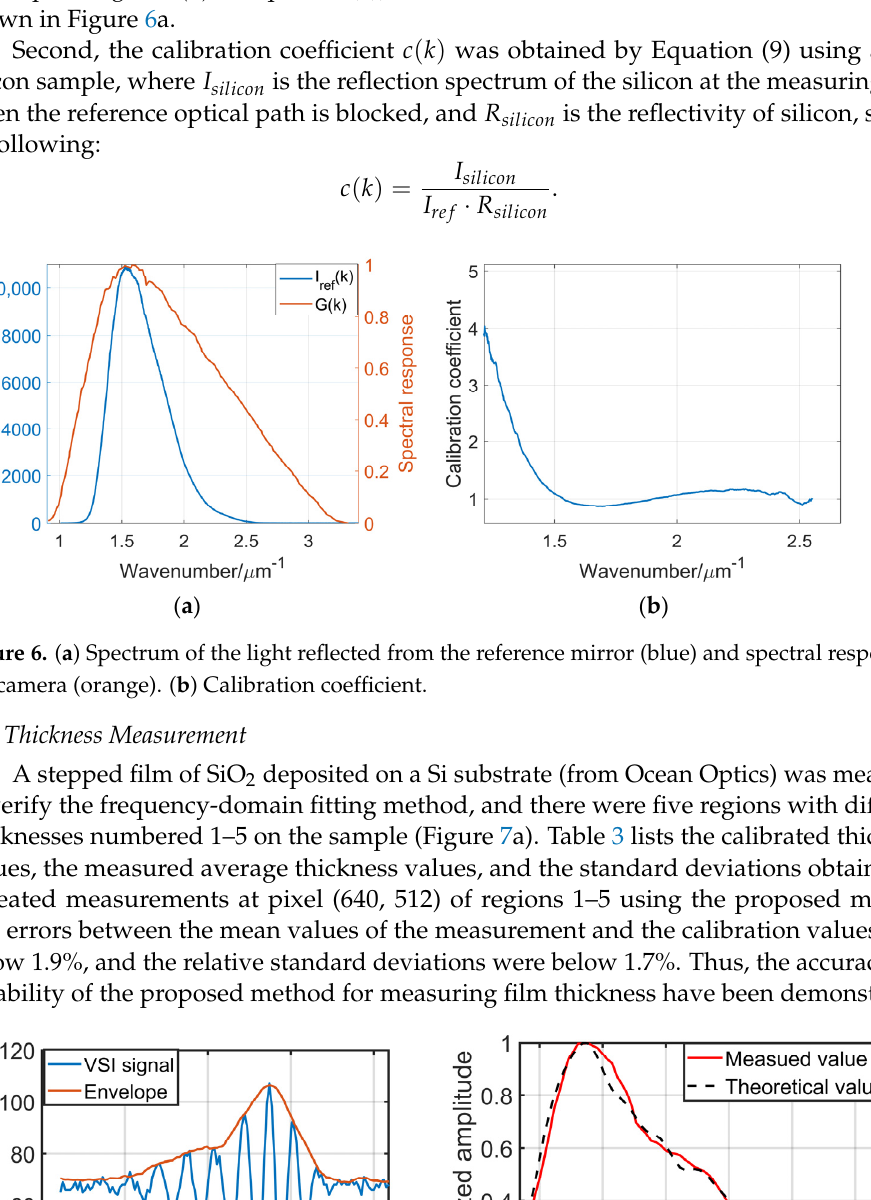
Table 3. Measurement results for the stepped samples.